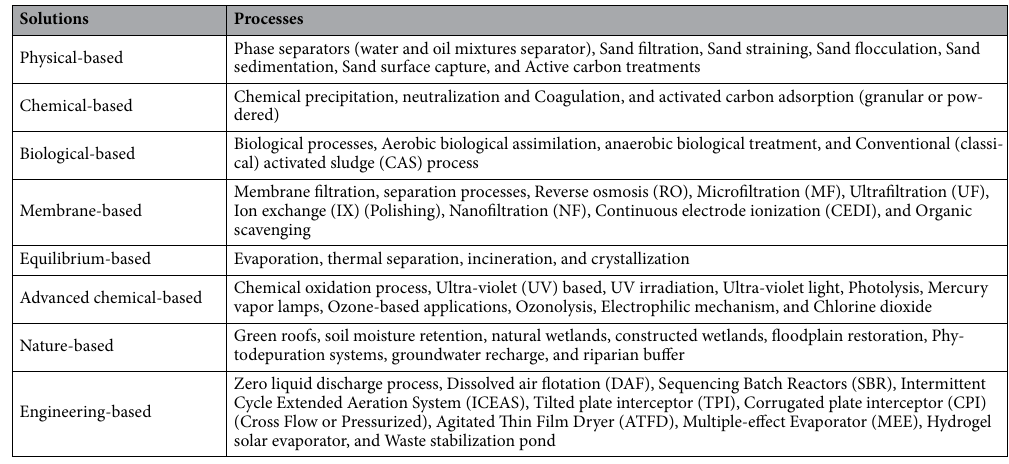
Table 6. Circular water solutions.